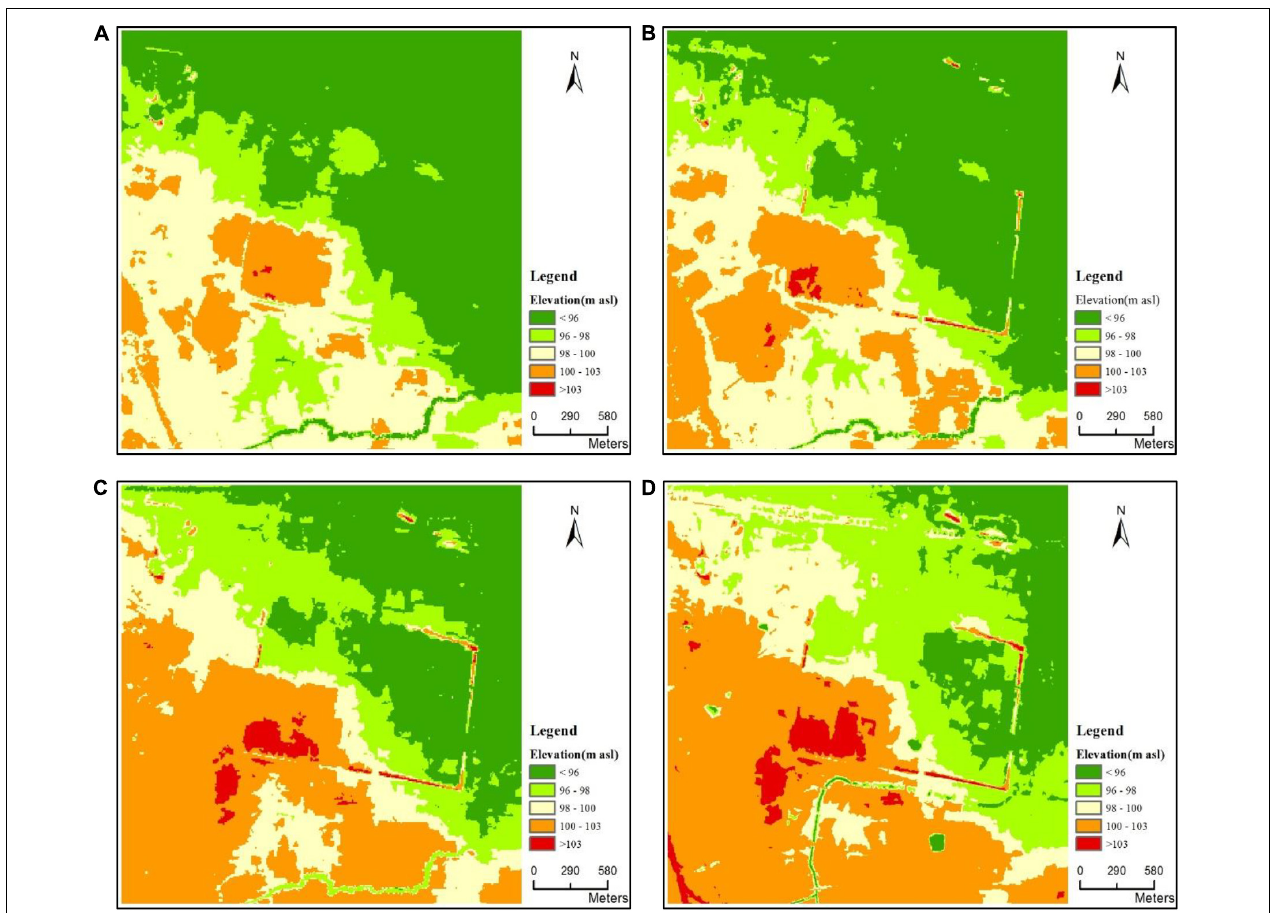
FIGURE 4 | The simulation of the ancient topography. (A) Late Pleistocene. The terrain was lower than present. The early course of the Xionger River is clearly shown in the south. (B) Shang Dynasty. The terrain was higher than late Pleistocene. People built the city walls according to the terrain. (C) Tang-Song Periods. Areas of high elevation continued to increase. People built some new walls in the middle of city. (D) Modern. The area has always maintained the topographic characteristics of a high area in the southwest and low area in the northeast since late Pleistocene. The Xionger River is artificially altered with the straighter watercourse.